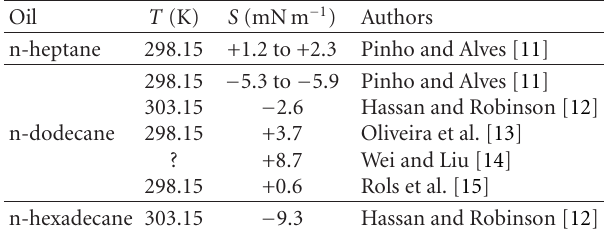
Figure 1: Variation of k L a for oxygen upon n-alkane addition reported in the literature for stirred tanks (filled symbols) and bubble columns (open symbols). Table 1: Literature values of spreading coe ffi cient S .